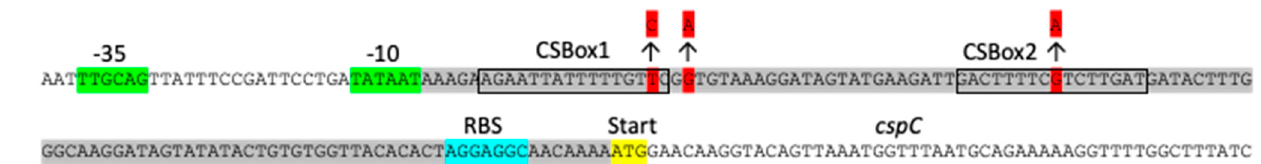
Figure 3. Genetic organization of the cspC promoter region. Sequence of the promoter region showing the − 35 and − 10 regions. The 5’UTR (RNA feature S179) is highlighted in grey. CSBoxes, cold shock boxes; RBS, ribosomal binding site; mutations found in ∆ cspB ∆ cspD suppressor mutants are highlighted in red.